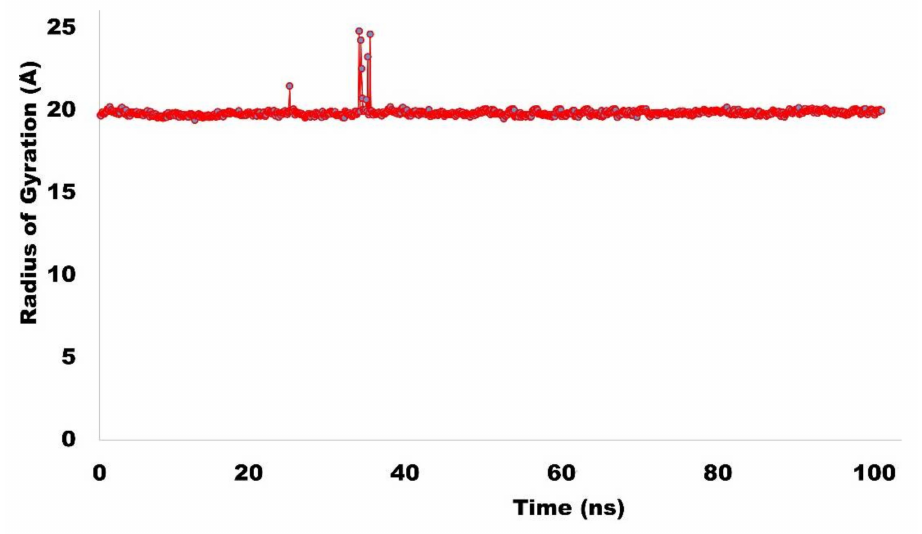
Figure 14. Radius of gyration